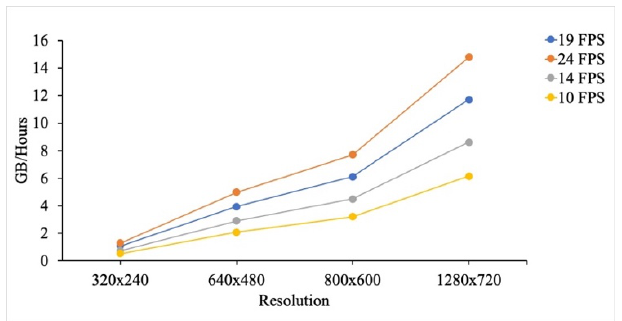
Figure 4. The effect of video resolution and frames per second (fps) on the MJPEG data transmitted per